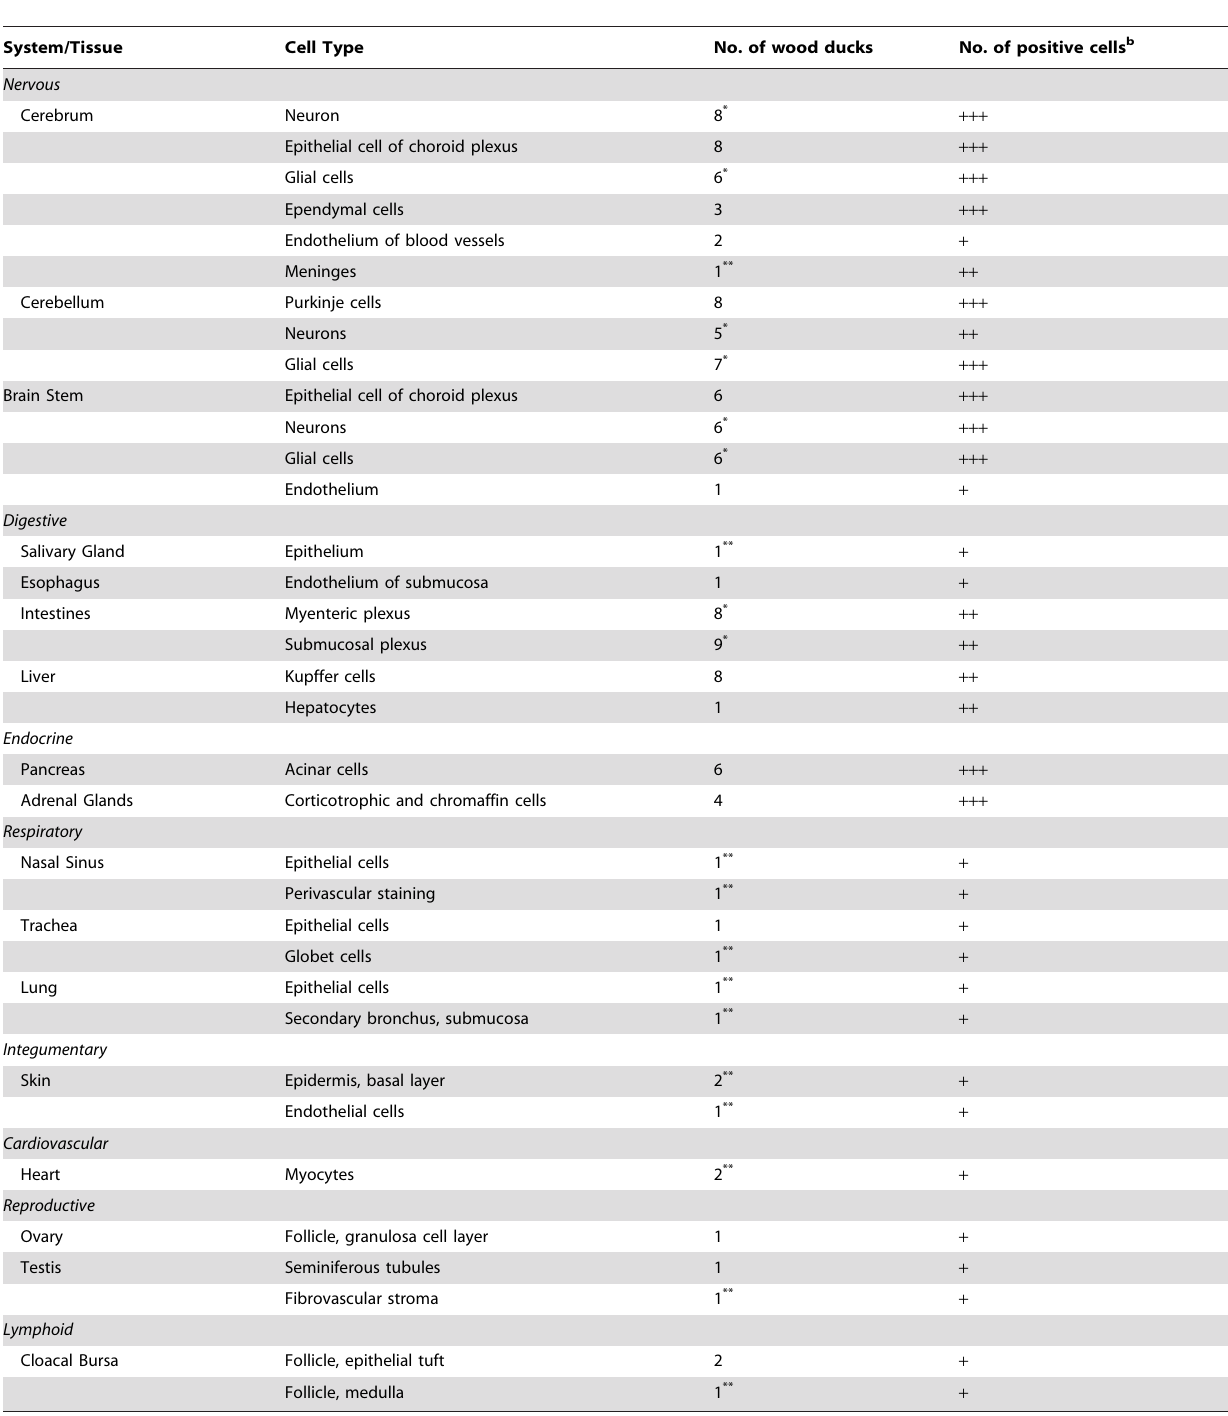
Table 5. Immunohistochemical analysis for nucleoprotein of avian influenza virus of wood ducks ( Aix sponsa ) that succumbed to infection (n=13) with the highly pathogenic avian influenza virus A/whooper swan/Mongolia/244/05 (H5N1) a .